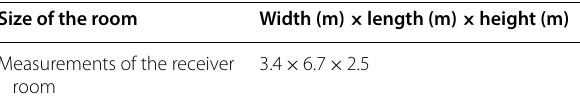
Table 5 Lightweight floor impact noise